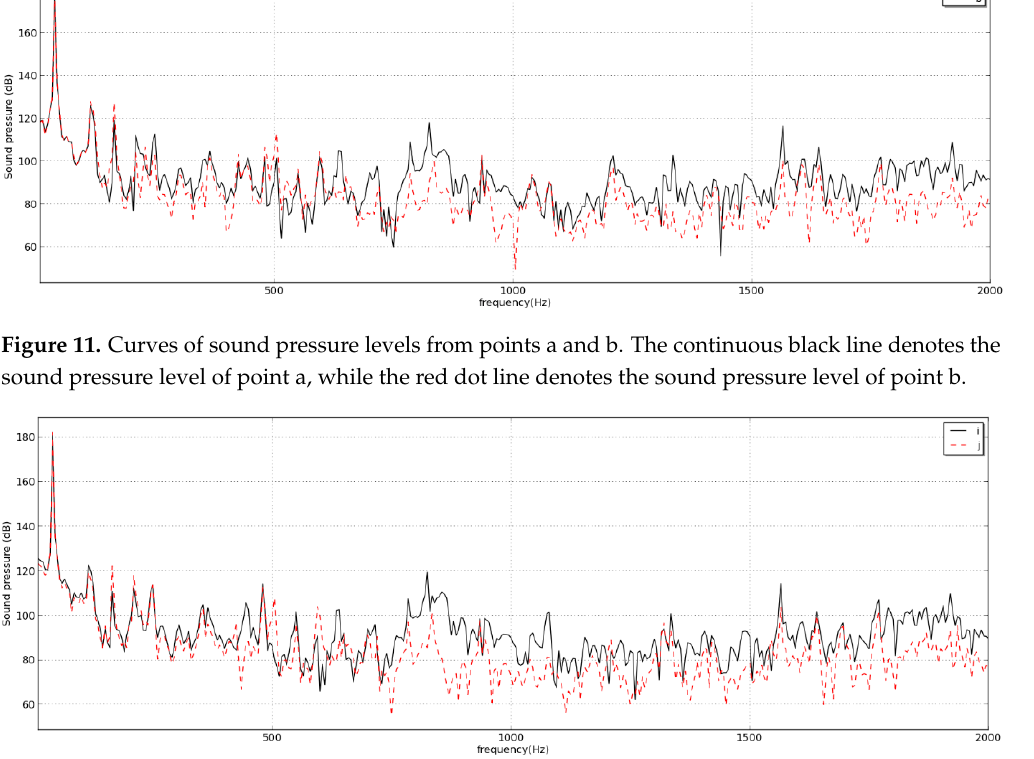
Figure 12. Curves of sound pressure levels from points i and j. The continuous black line denotes the sound pressure level of point i, while the red dot line denotes the sound pressure level of point j.